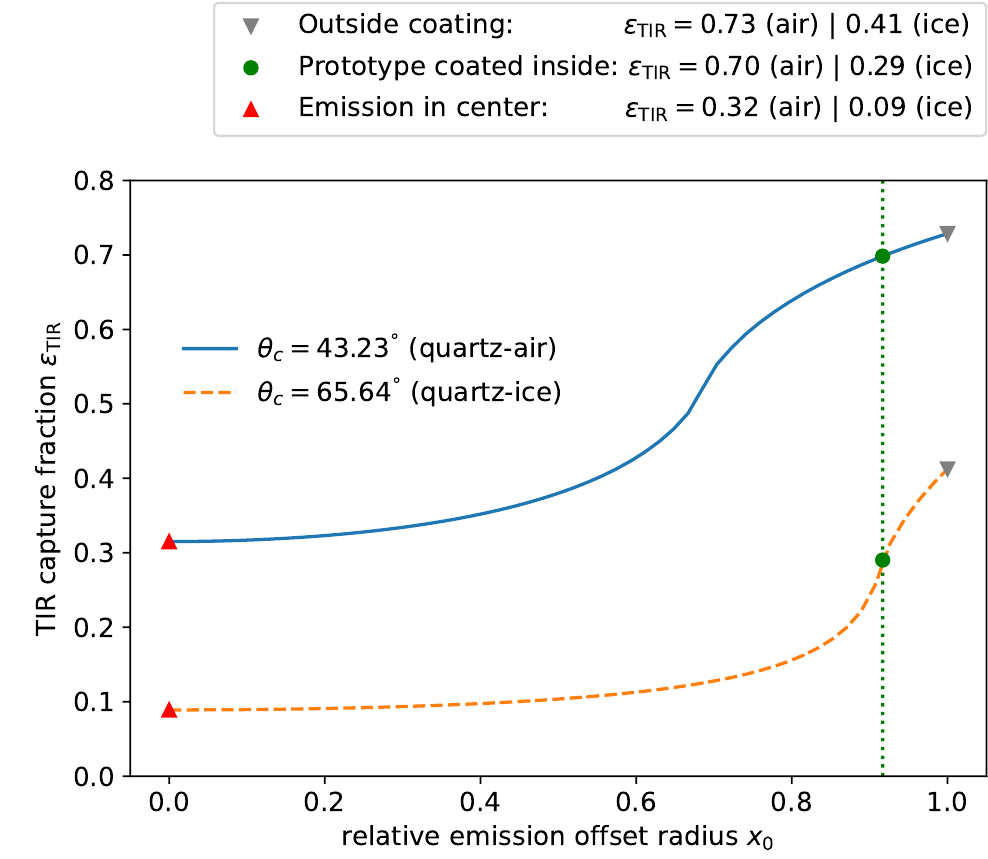
Figure 4. Fraction (cid:101) TIR of the solid angle under which emitted photons are captured by total internal reflection as a function of the offset radius x 0 of the emission point. The two lines represent a module immersed in air (solid) or water (dashed). The green dots indicated the captured efficiency for the prototype module, which is coated on the inside of tube. Minimal values for the emission point in the center of the tube and maximal values for emission on the outside of the tube are indicated by